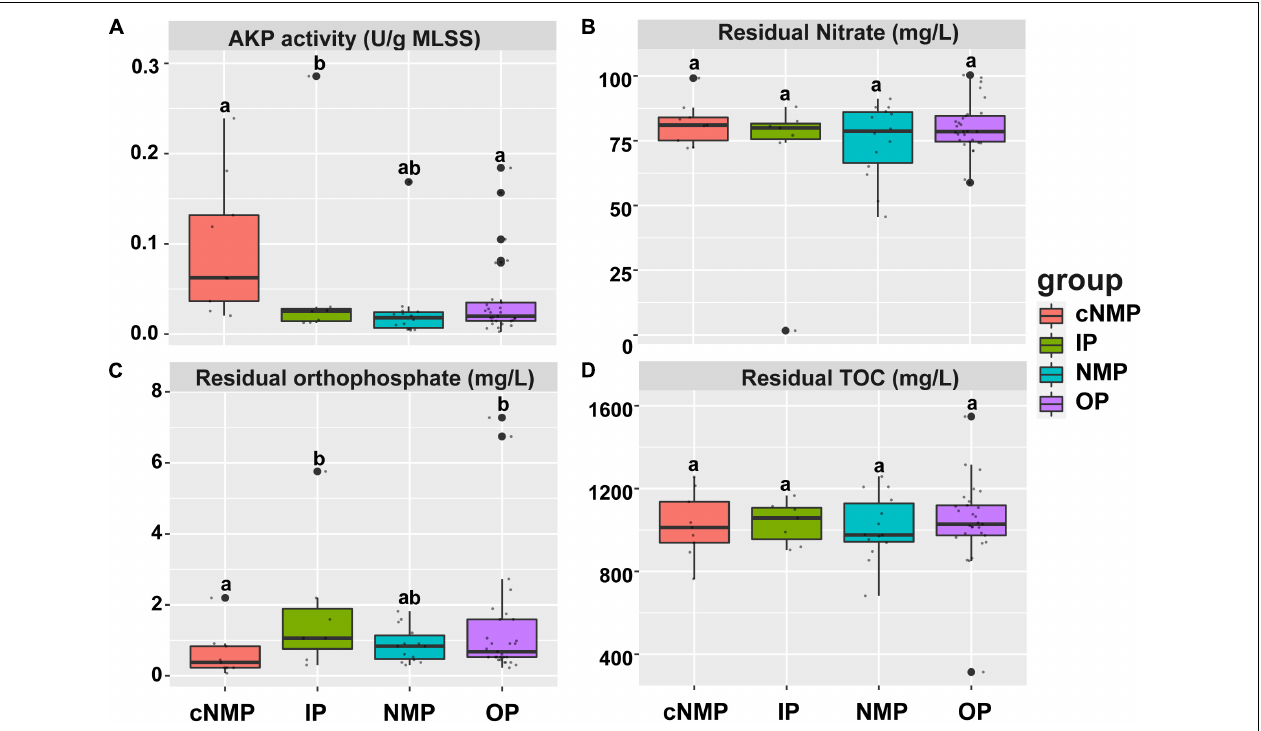
FIGURE 1 | (A) Relative AKP activity, (B) residual nitrate, (C) residual orthophosphate, and (D) residual TOC of DPR with four phosphorus sources after 60 h of cultivation. The top and bottom boundaries of each box represent the 75th and 25th quartile values, respectively; and the line within each box represents the median values ( n = 9, 7, 14, and 29). Different letters indicate significant differences at the p < 0.05 level. AKP, alkaline phosphatase; TOC, total organic carbon; DPR, denitrifying phosphorus